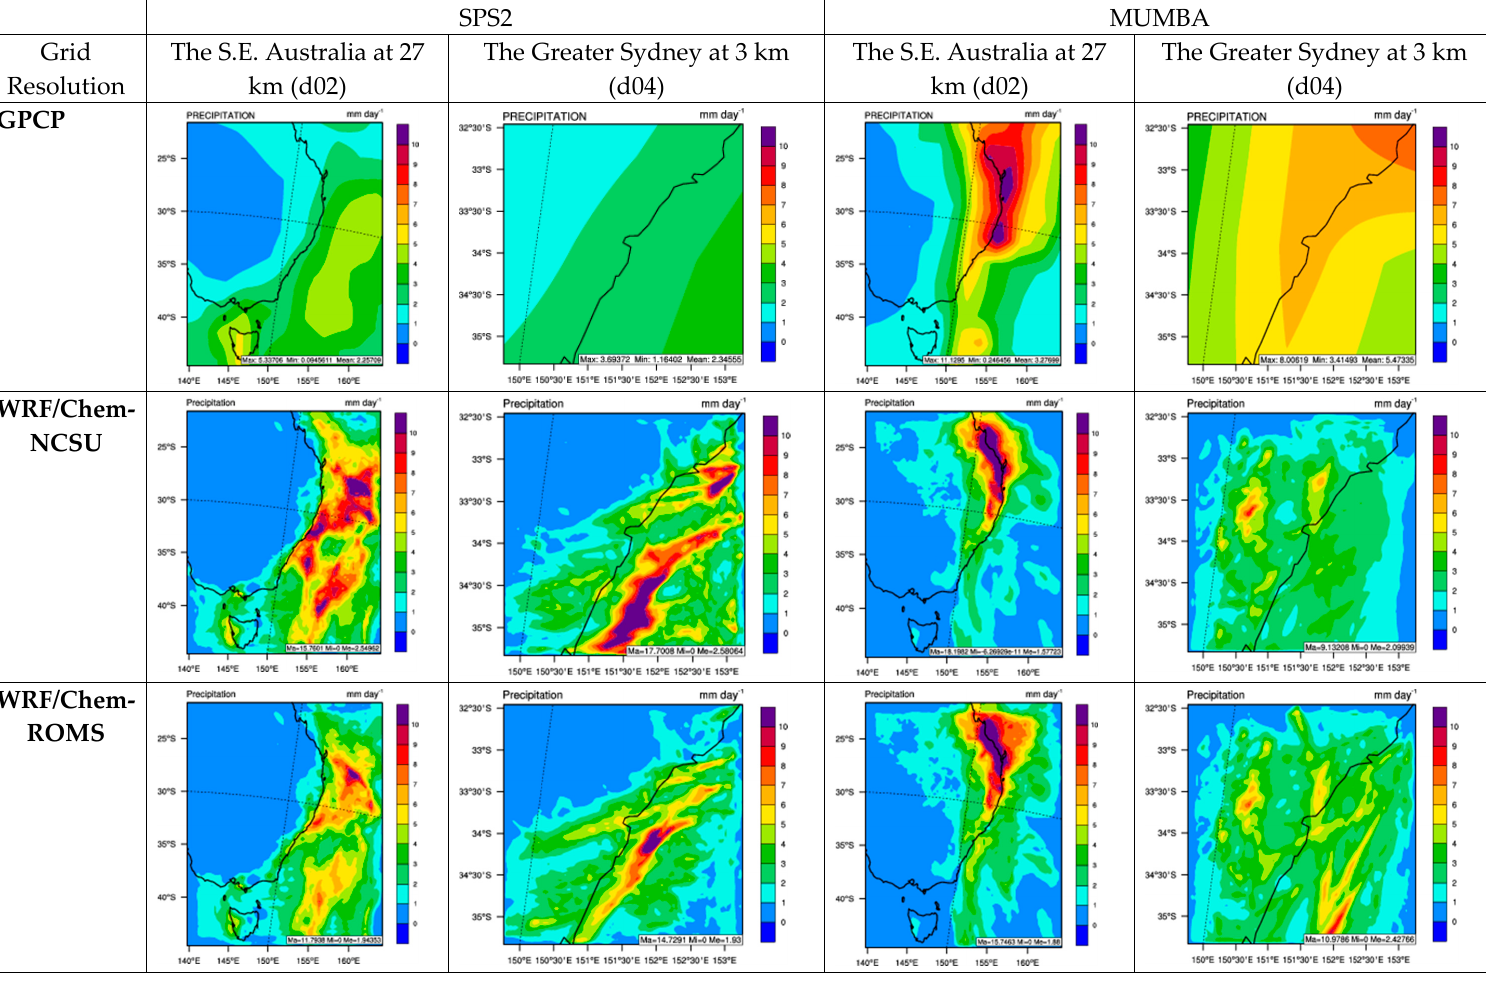
Figure 9. Observed and simulated precipitation over southeastern Australia at 27 km (d02) and the Greater Sydney at 3 km (d04) during SPS2 and MUMBA. Two sets of simulation results at 3 km are compared, one from WRF/Chem-NCSU and one from WRF/Chem-ROMS.